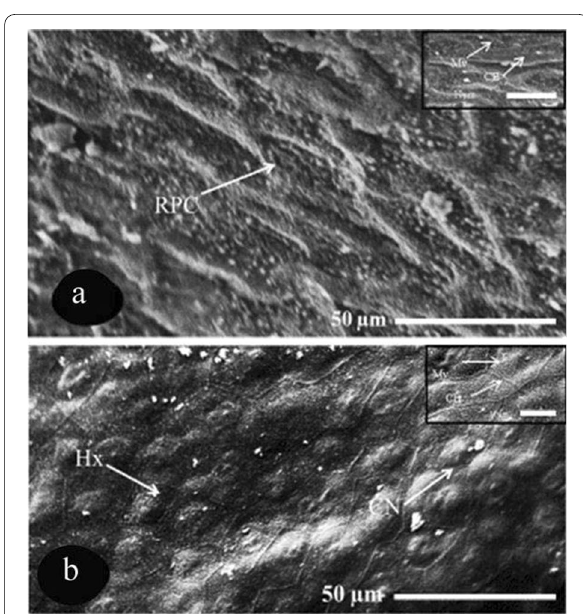
Fig. 3 SEM micrograph of the corneal epithelial cells in a Anas platyrhuncus , b Buteo buteo showing: hexagonal cells (HX); regular polygonal cells (RPC) and Central Nuclei (CN) (Scale bar, 50 µm). The intercept showing higher magnification of SEM micrograph of a Anas platyrhuncus , b Buteo buteo. Note : Microvilli (Mv) and Cell Borders (CB)